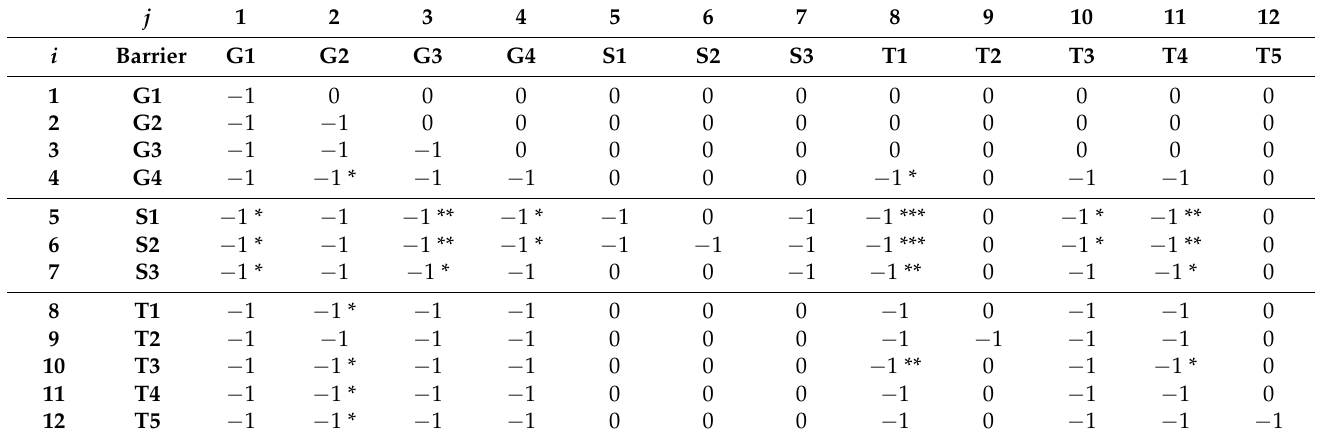
Table 7. Final Negative Reachability Matrix ( − RM fin ).